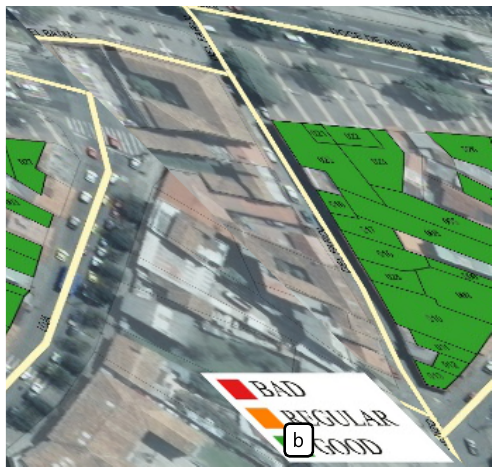
Figure 2b: The condition of the buildings in the Diagnosis phase, after de Campaign (2014). Source: vlirCPM project.